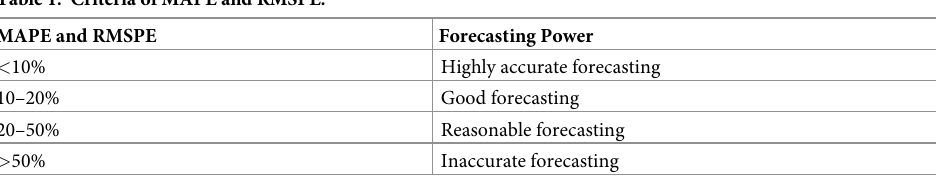
Table 1. Criteria of MAPE and